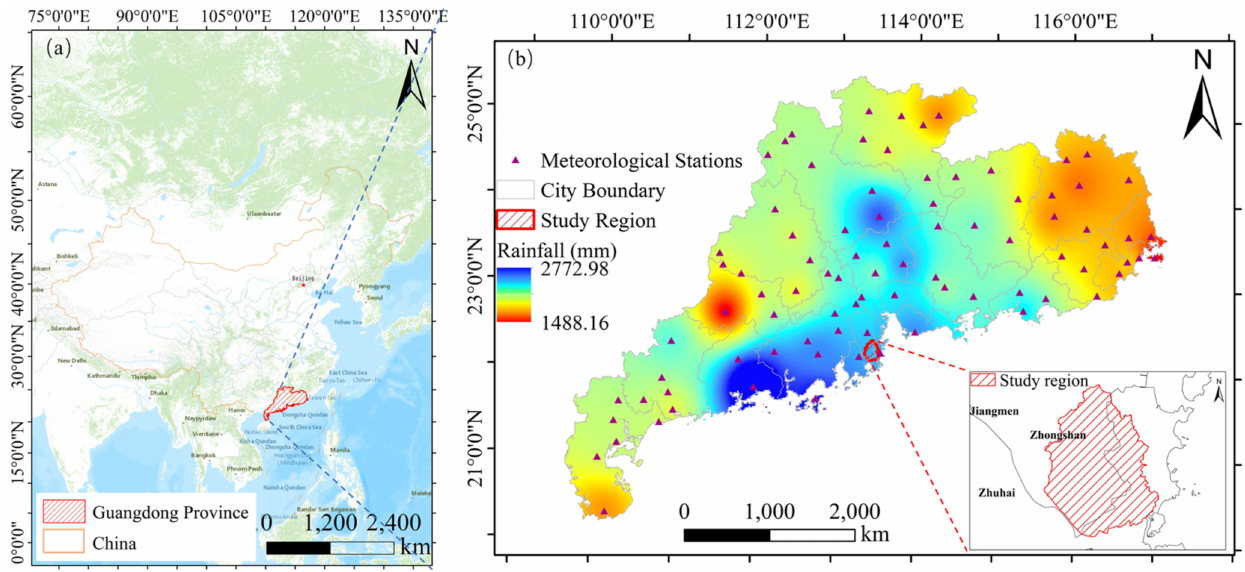
Figure 1. Location of the study area and related display. ( a ) Location of Guangdong Province; ( b ) location of the study area and average annual precipitation from 2000 to